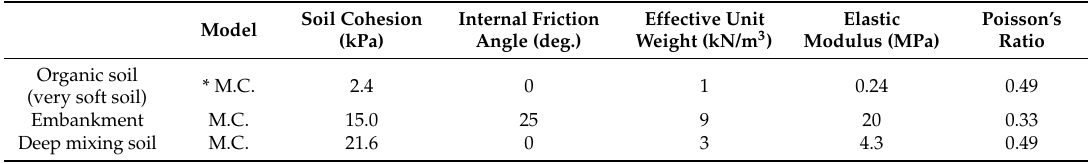
Table 2. Input parameter for Coupled Eulerian–Lagrangian (CEL) analyses (Korea Institute of Getechnology [28]).